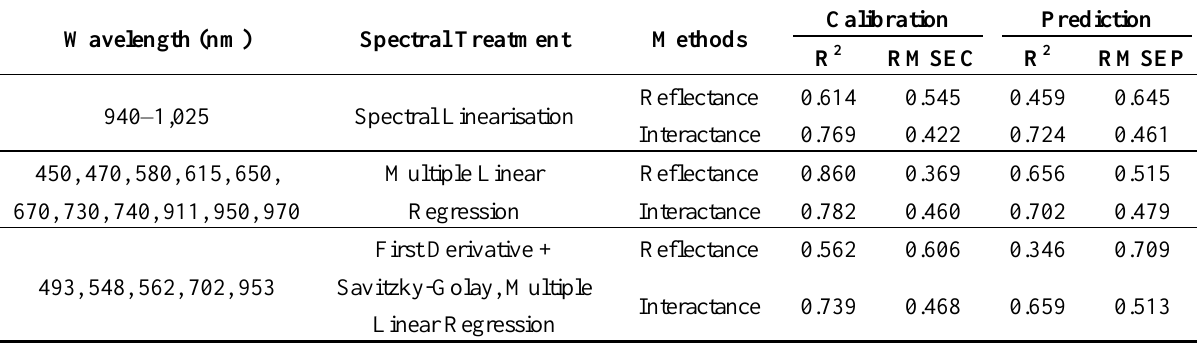
Table 2. Results obtained through MLR on visible and NIR spectroscopy